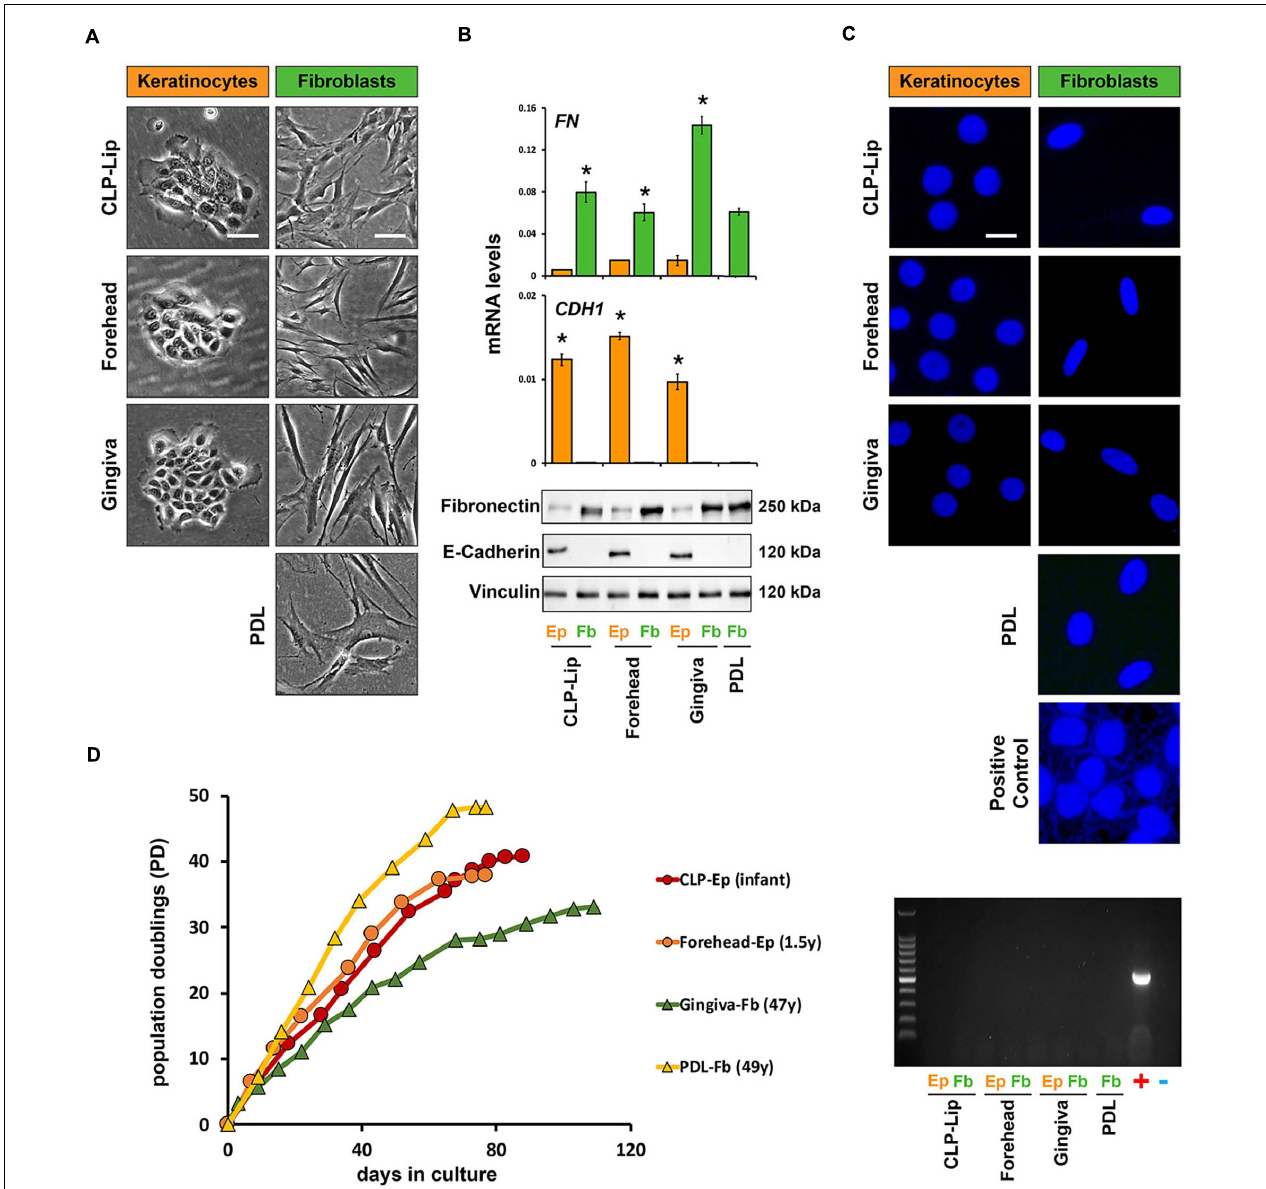
FIGURE 3 | Before biobanking, newly isolated cell cultures undergo a standardized quality control check. (A) In a representative set of primary cells (CLP-Lip, Forehead, Gingiva, and PDL) live imaging pictures show typical cell morphologies of the patient-derived keratinocytes (orange) and fibroblasts (green). While keratinocytes form tightly packed and cohesive colonies, fibroblasts appear with an elongated and spindle-like shape. Scale bar: 50 µ m. (B) The same set of primary cells was used for qPCR (top) and immunoblot analysis (bottom) confirming E-Cadherin ( CDH1 ) and fibronectin ( FN ) expression in keratinocytes (orange bars) and fibroblasts (green bars), respectively. Data are expressed as mean ± SD. n = 3. (C) Mycoplasma contamination of the new cell cultures is tested by DAPI staining of the nuclei and a PCR-based mycoplasma detection analysis. DAPI staining and PCR amplifications are shown to confirm absence of mycoplasma contamination in the same representative set of newly isolated primary cell cultures. Scale bars: 25 µ m (Live Imaging keratinocytes), 50 µ m (Live Imaging fibroblasts), 10 µ m (DAPI). +positive control; –negative control; PDL: periodontal ligament. * p < 0.05 Ep vs. Fb. (D) Lifespan analysis of two representative keratinocyte (CLP lip, red, and forehead, orange) and two fibroblast strains (gingiva, green, and PDL, yellow) reveals that all cell cultures tested have a replicative potential of at least 35 population doublings (PD). The age of the tissue donors is indicated in the brackets. Y: year; Ep: epithelial cells; Fb: fibroblasts.